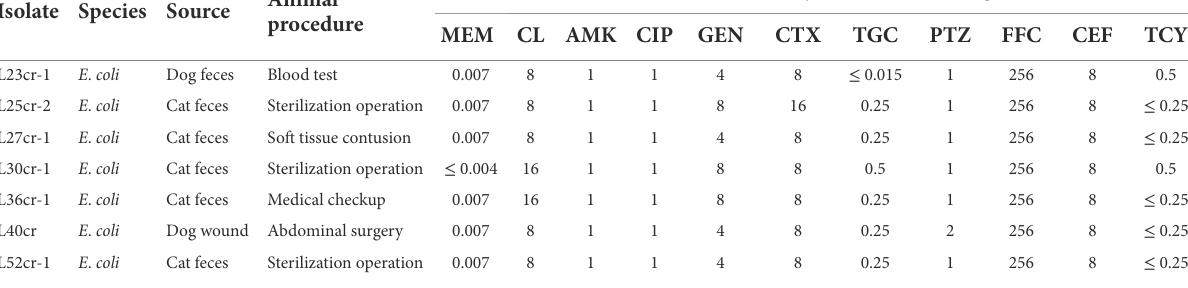
TABLE 1 Antimicrobial susceptibility profiles of 7 mcr-1 -positive Escherichia coli (MCRPEC) isolates from companion animals at a pet hospital in Shanghai, China.